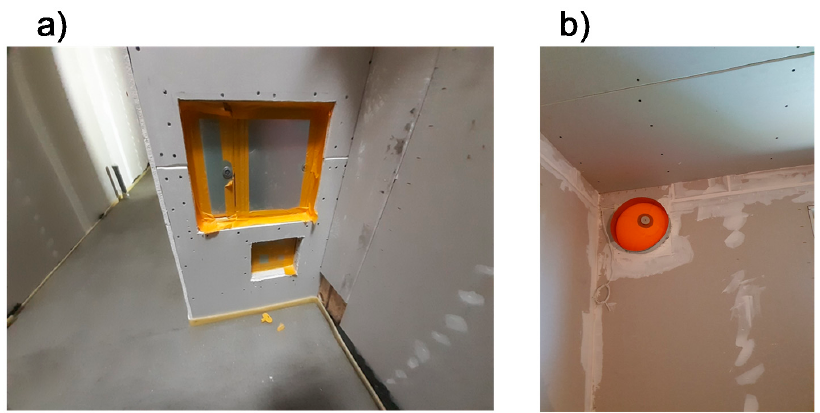
Figure 7. Sealed potential places of uncontrolled air leak ( a ) inspection door ( b ) mechanical ventila- tion outlet.